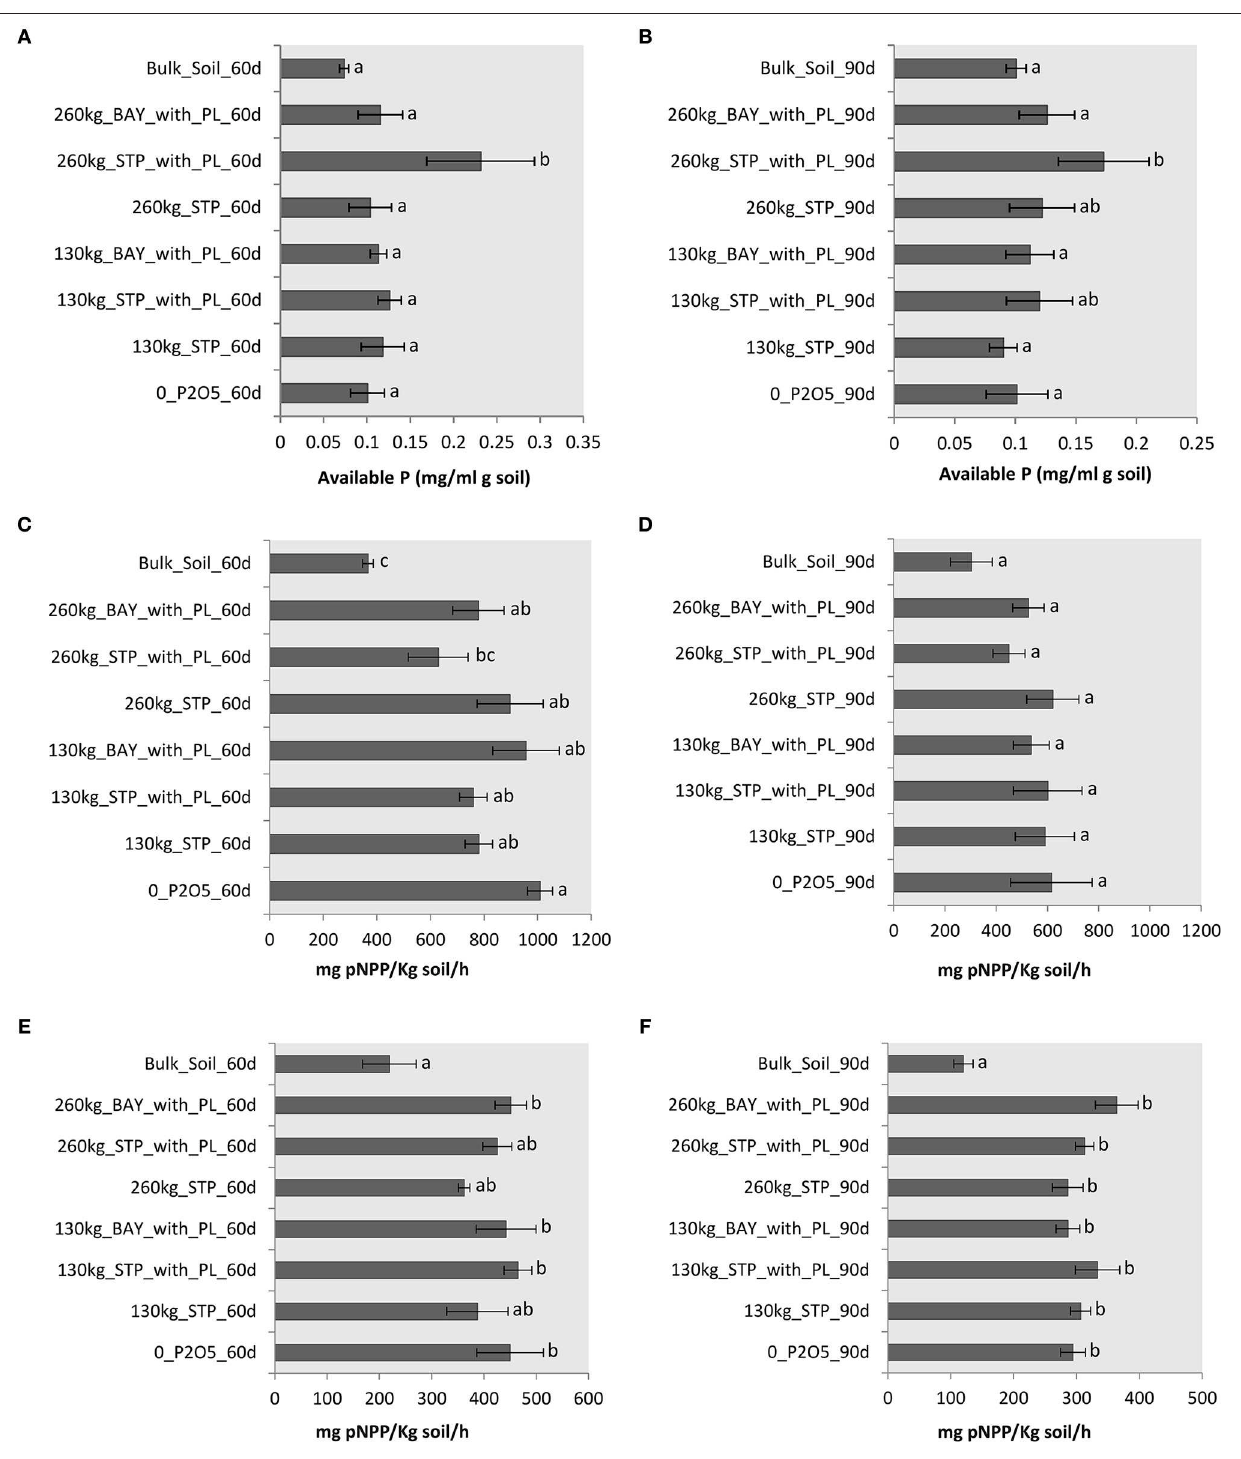
Frontiers in Environmental Science |